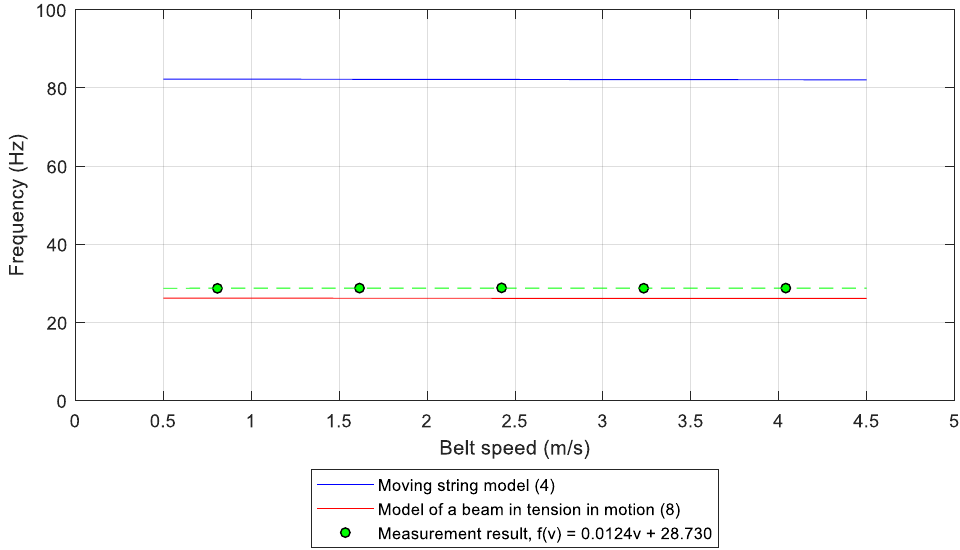
Figure 5. The frequency of transverse vibrations as a function of belt speed, for support spacing L = 1.2 m compared with the results predicted by the theoretical models of a string and of a beam (for a tensile strength of 40 kN).